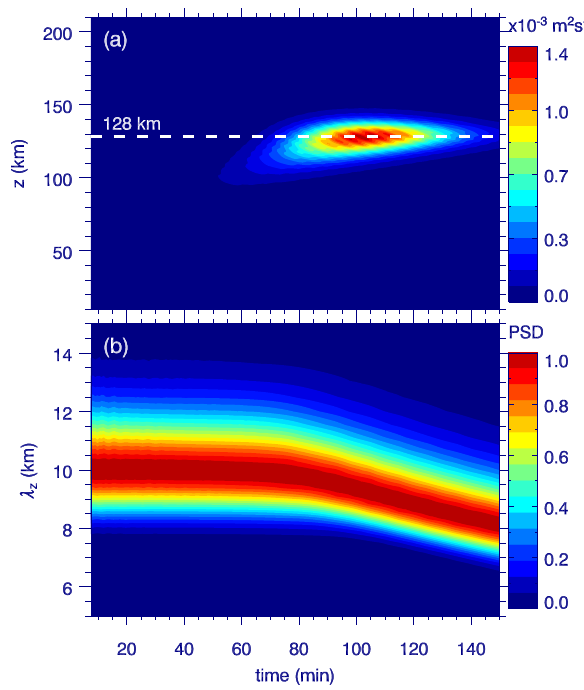
Fig. 4. Temporal evolutions of (a) momentum flux and (b) normal- ized vertical wavelength power spectra for the GW shown in Fig.